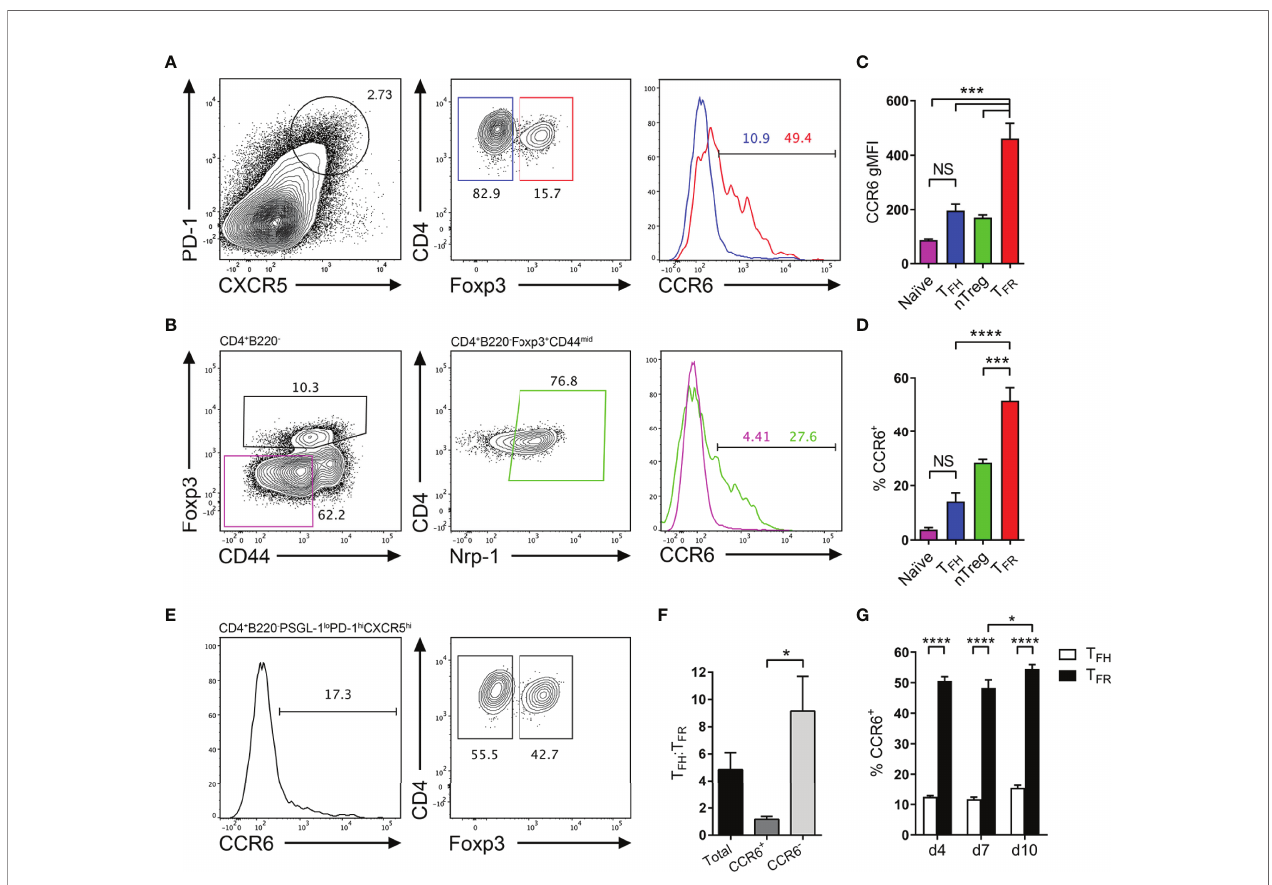
FIGURE 2 | CCR6 expression is highest in T FR cells amongst follicular T cell populations. (A, B) Representative gating strategy for CCR6 + T FH cells (CD4 + B220 - CXCR5 hi PD-1 hi Foxp3 - ), T FR cells (CD4 + B220 - CXCR5 hi PD-1 hi Foxp3 + ), naïve CD4 T cells (CD4 + B220 - CD44 lo Foxp3 - ) and natural T-regulatory cells (nTreg: CD4 + B220 - CD44 mid Foxp3 + Nrp-1 + ) 6 days after SRBC immunization. (C) Geometrical mean fl uorescence intensity (gMFI) of CCR6 and, (D) percentage of CCR6 + cells within populations from (A) and (B) . (E) Representative gating strategy for T FH (Foxp3 - ) and T FR cells (Foxp3 + ) within CCR6 + follicular T cells (CD4 + B220 - CXCR5 hi